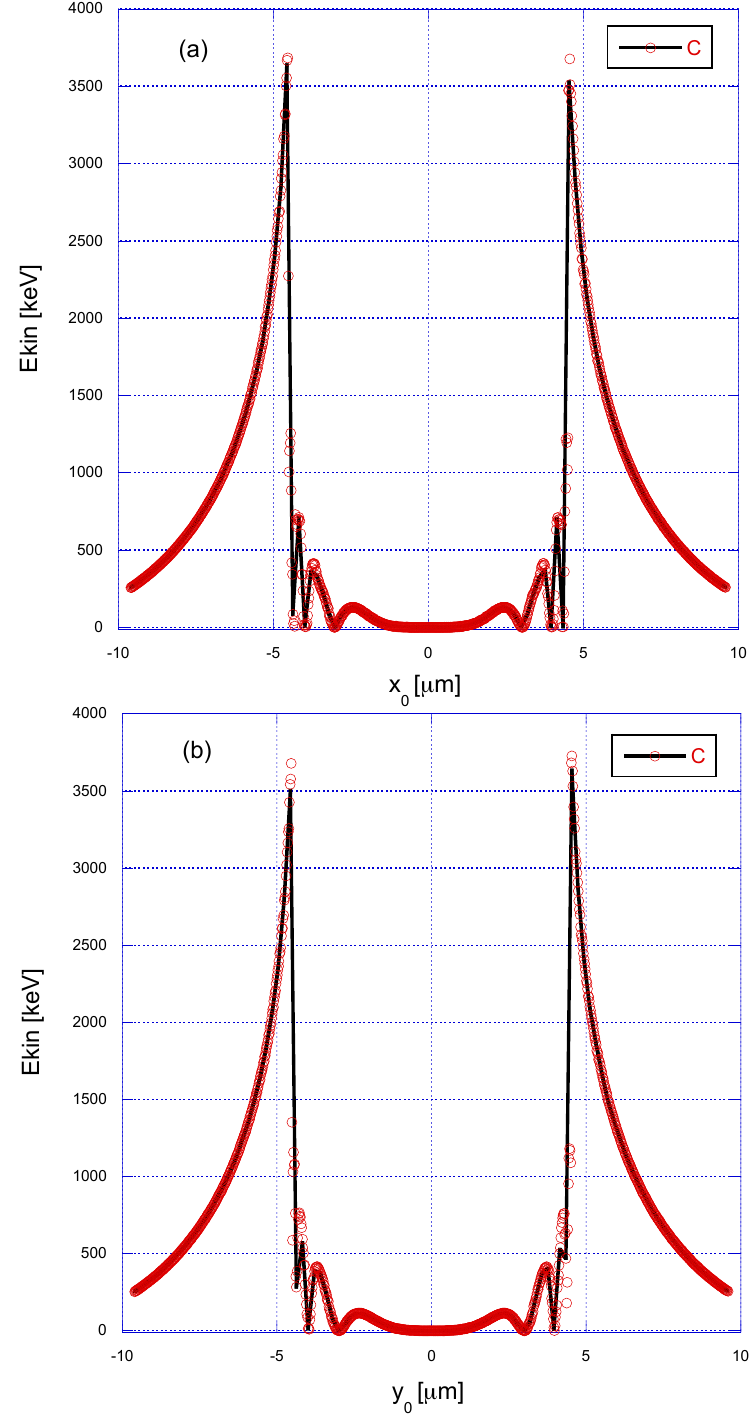
Figure 16. Asymptotic values of the kinetic energy for initial conditions of the form x 0 ∈ [ − 1.5 × w 0 , 1.5 × w 0 ] , y 0 ∈ [ − λ 0 /2, λ 0 /2 ] , z 0 = 0 ( a ), and y 0 ∈ [ − 1.5 × w 0 ,1.5 × w 0 ] , x 0 ∈ [ − λ 0 /2, λ 0 /2 ] , z 0 = 0 ( b ). w 0 = 6.4 µ m in this case. Red circles correspond to the computed initial conditions, black lines are cubic spline fittings to the data. Note that the two prominent peaks of E kin are very close to √ ± w 2, the region where the OAM mode with ( l , p ) = ( 1,0 ) is known to trap electrons due to the 0 / ponderomotive force. The 90 ◦ symmetry of the asymptotic kinetic energy distribution is apparent from this